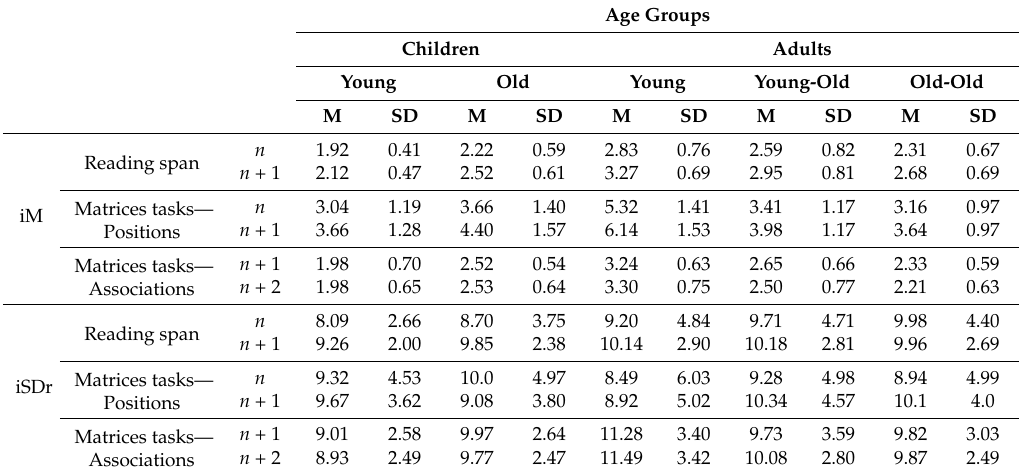
Table A4. Accuracy tasks: Means (iM) and intra-individual standard deviation of residual scores (iSDr) by Age group (five